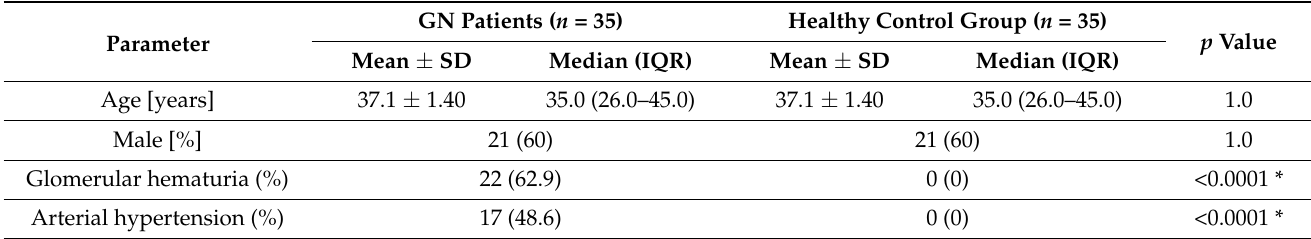
Table 1. Clinical characteristics of the GN patients and the control